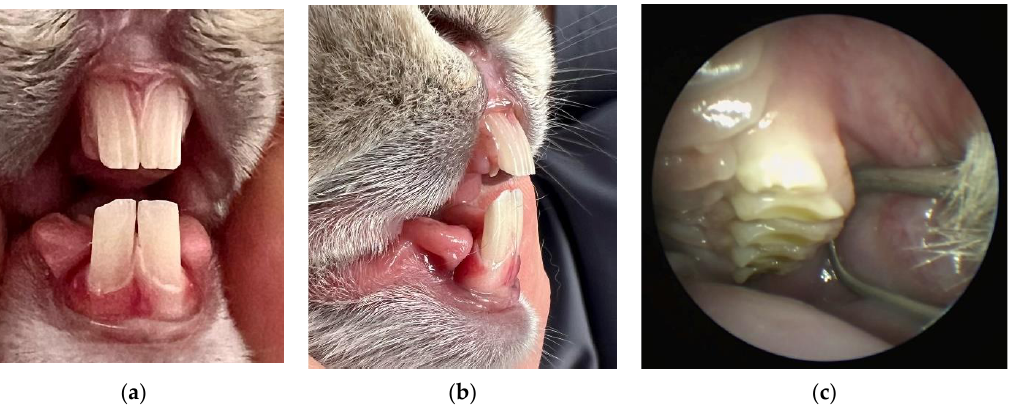
Figure 2. Rabbit teeth: incisors frontal view — overbite ( a ) incisors lateral view — overjet ( b ) and premolars and molars view ( c ) (by Jakub Kotowicz).